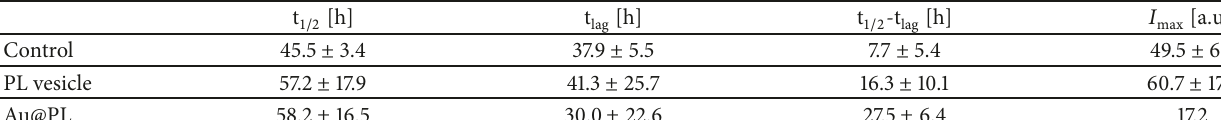
Table 1: Kinetic parameters in A 𝛽 fibrillation.